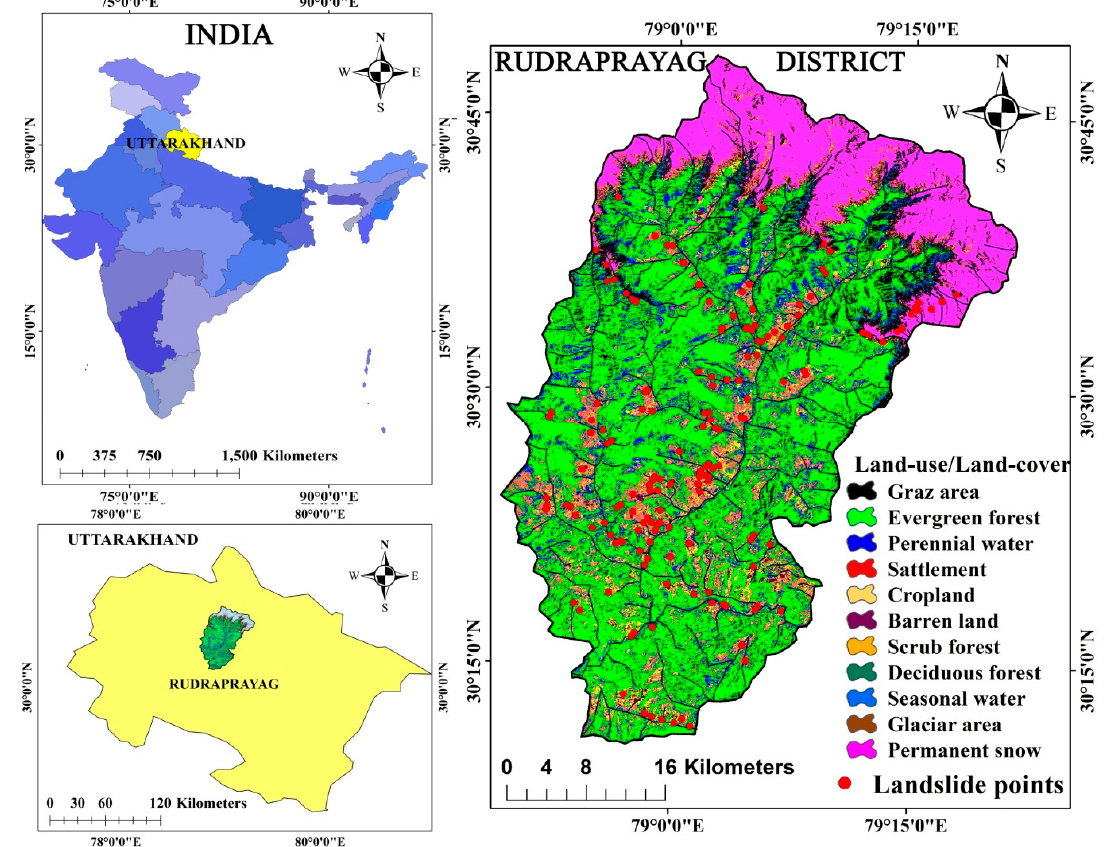
Figure 1. Location map of the study area with landslides.